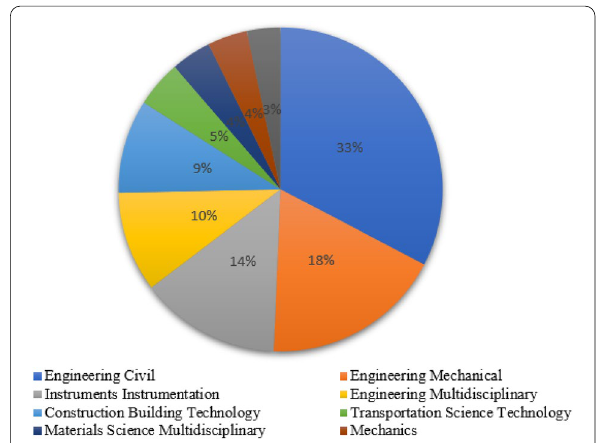
Fig. 1 Application fields of vibration-based structural health monitoring (years